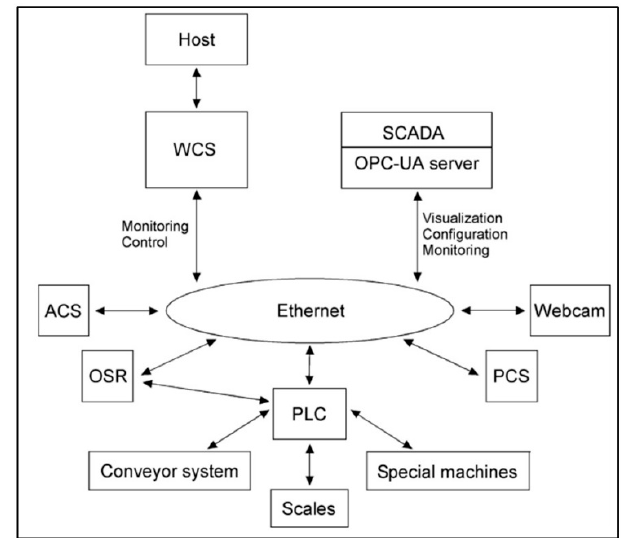
Figure 7. System hierarchy for retail sporting goods operation.